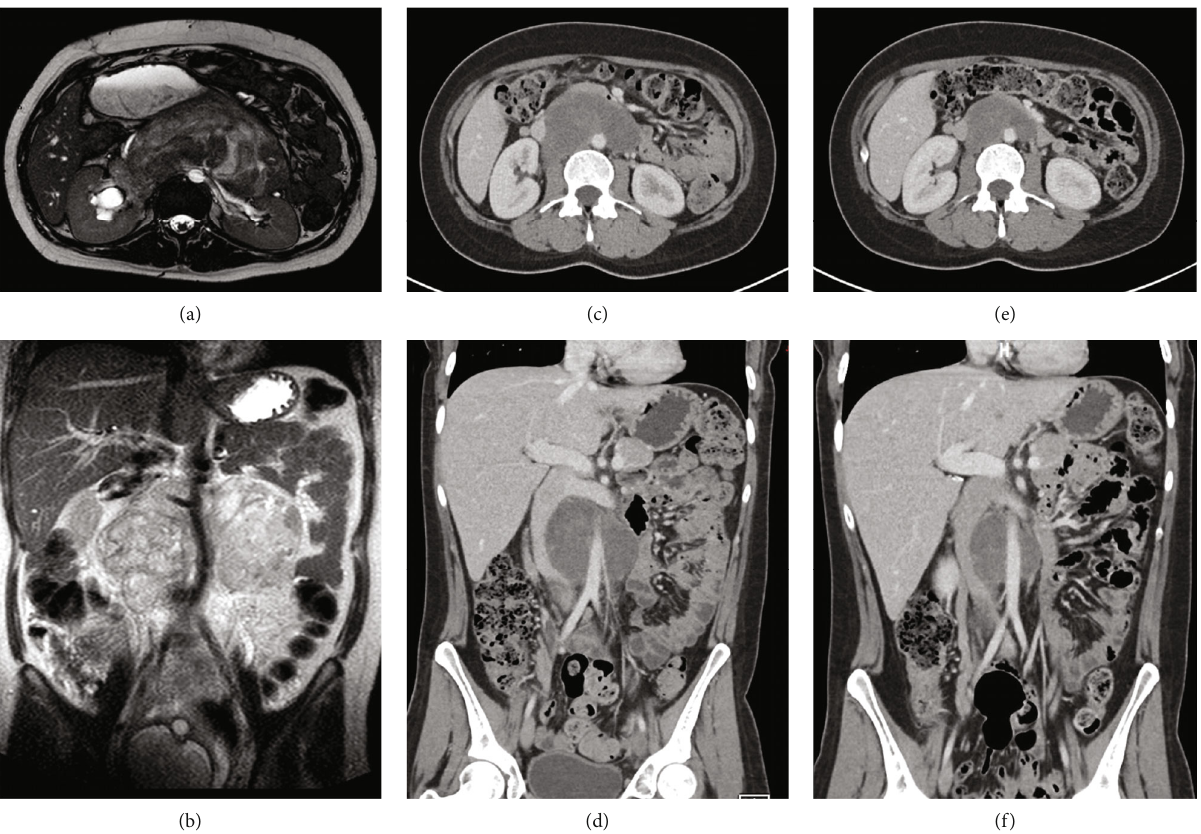
Figure 1: Radiology of synovial sarcoma case. Magnetic resonance imaging prior to treatment (a, b) demonstrating the large retroperitoneal mass. (a) Fluid sensitive axial image shows the mass partially encasing the abdominal aorta and compressing and displacing the inferior vena cava. Mild right hydronephrosis is evident. (b) T2 coronal image showing extensive encasement of the aorta and right renal artery by the large retroperitoneal mass. Computed tomography imaging post 3 cycles (c, d) and 6 cycles (e, f) of neoadjuvant chemotherapy demonstrating treatment response as evidenced by marked decrease in tumor size, decreased mass e ff ect on the vena cava, resolution of right hydronephrosis, and deceased tumor density (suggestive of